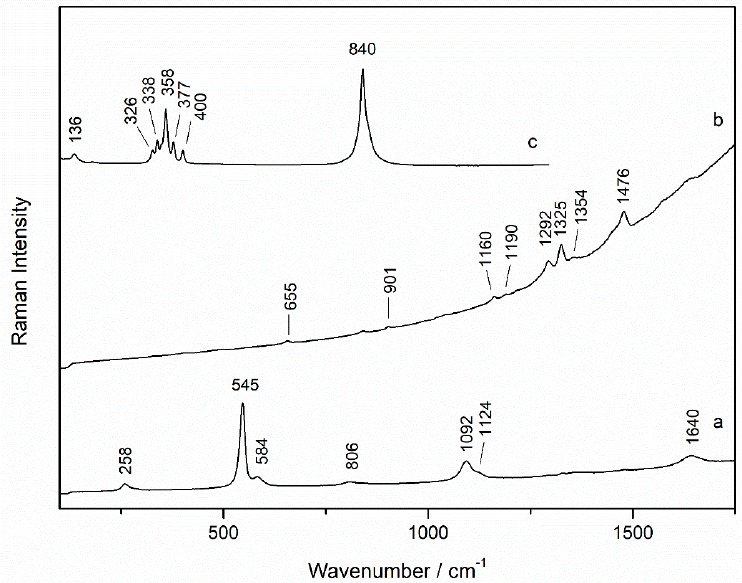
Figure 3. Raman spectra of ( a ) ultramarine blue, ( b ) alizarin red (532 nm excitation laser), and ( c ) lead chromate (785 nm excitation laser) from a purple area (sample wp2).